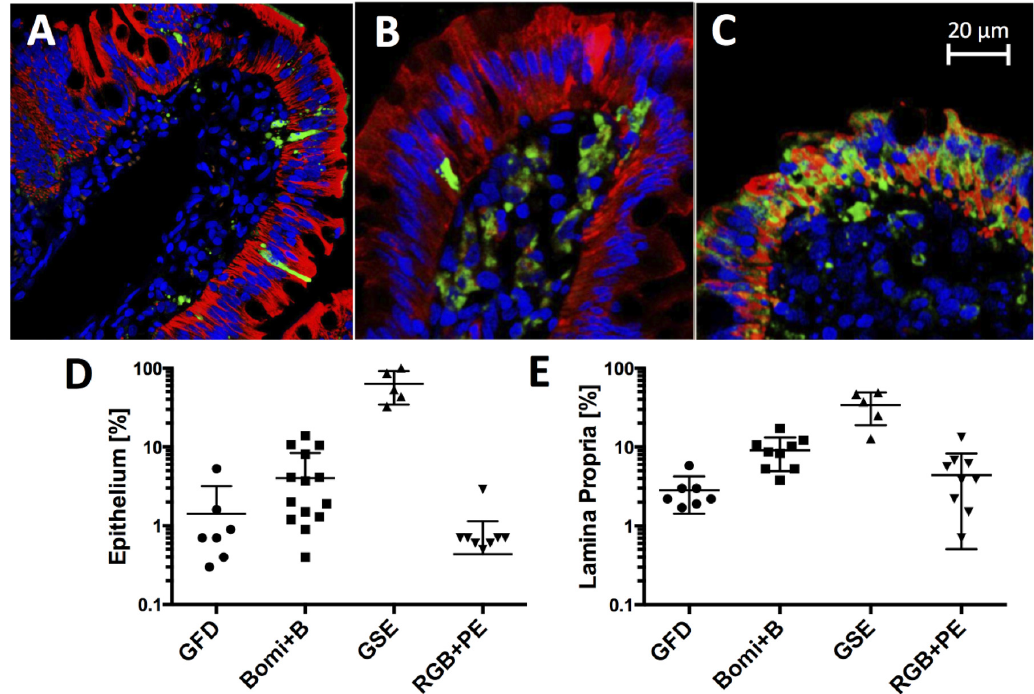
Figure 4. The combination of cytokeratin 1 ( red = epithelial cells), active caspase ( green = cells undergoing apoptosis) and diamino-2-phenylindole (DAPI, blue = nuclear DNA) antibodies was used to examine the diet-induced changes within intestinal mucosa. Jejunum from juvenile GS macaques on gluten-free diet (GFD) shows prominent red staining corresponding to epithelial cells with very few of the green cells ( A ); Jejunum from macaque on Bomi + B diet shows an increased number of green/apoptotic cells positive for active caspase inside the lamina propria (LP) ( B ); Control jejunum tissue from an adult macaque with gluten-sensitive enteropathy (GSE) exhibits high % of epithelial apoptotic cells ( C ); Charts reflecting the proportions (%) of apoptotic cells inside the epithelium ( D ) and LP ( E ) of GS macaques fed dietary gluten-modified diets in this study plus the control GSE macaques fed regular monkey (gluten-containing) chow are